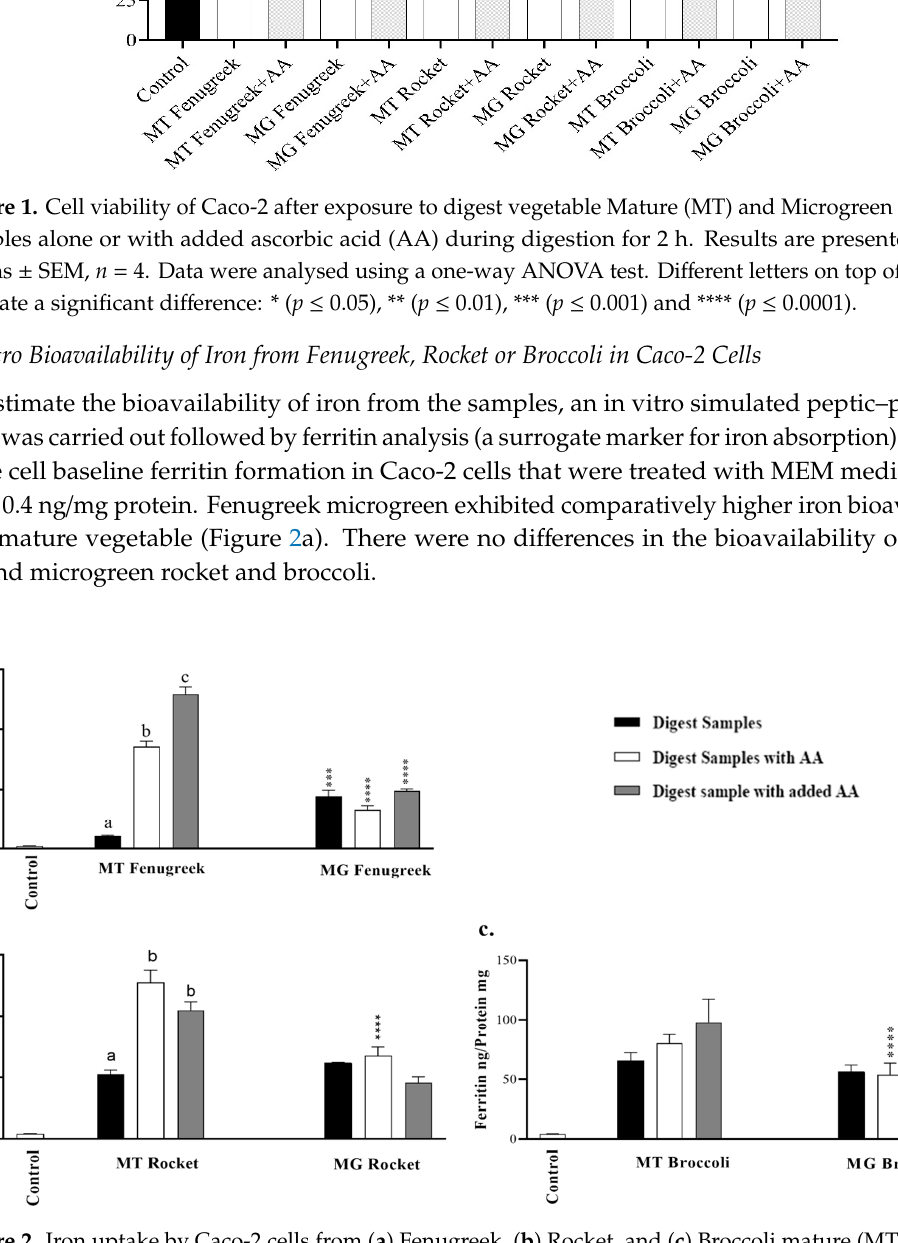
Figure 2. Iron uptake by Caco-2 cells from ( a ) Fenugreek, ( b ) Rocket, and ( c ) Broccoli mature (MT) and microgreen (MG) vegetables alone, with added ascorbic acid (AA) during digestion and vegetable samples with AA added during exposure to cells. The control treatment represents ferritin formation in Caco-2 cells in the presence of extract containing only the digestive enzymes. Results are presented as means ± SEM, n = 6. Data were analysed using a two-way ANOVA test. Different letters on top of bars indicate significant differences ( p ≤ 0.05) between data in the same group. The differences between MT and MG groups of the same vegetables are denoted: *( p ≤ 0.05), **( p ≤ 0.01), ***( p ≤ 0.001) and ****( p ≤ 0.0001). To enhance iron extraction during the peptic-pancreatic digestion of the mature and microgreen fenugreek, rocket and broccoli, ascorbic acid was added to the samples during the digestion process. With the exception of mature fenugreek and rocket, extracts displayed no enhancing effect of adding ascorbic acid during in vitro digestion on iron uptake in Caco-2 cells (Figure 2). Moreover, ascorbic acid significantly ( p ≤ 001) enhanced iron uptake from mature fenugreek and rocket when added directly to Caco-2 cells.